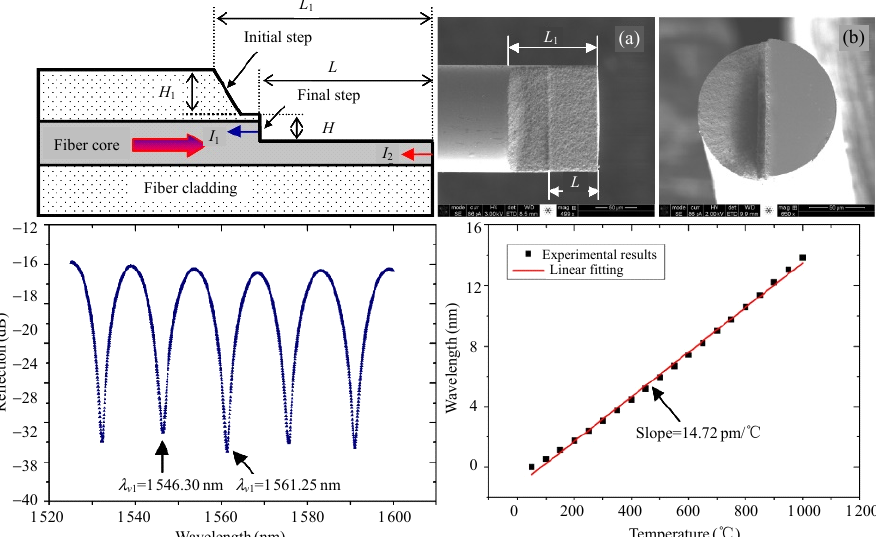
Fig. 25 Schematic diagrams of MI without splicing based on the step-structured fiber, and its spectra and temperature response